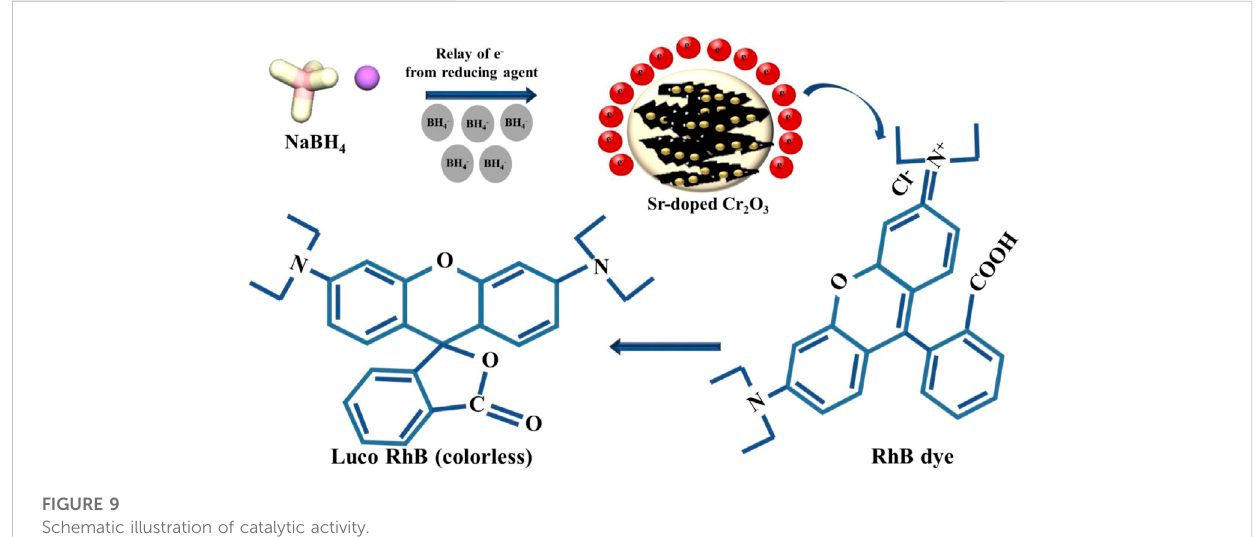
FIGURE 9 Schematic illustration of catalytic activity.